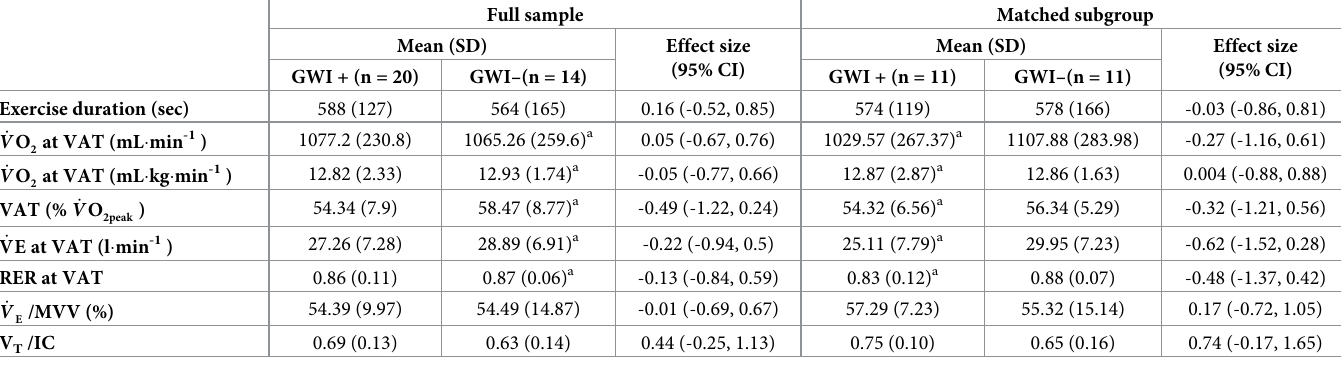
Table 4. Continued comparison of mean (SD) cardiopulmonary exercise data between participants with positive and negative Gulf War Illness diagnoses.